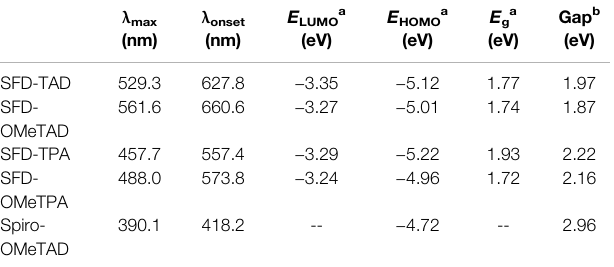
TABLE 1 | The optical and parameters of the target products.